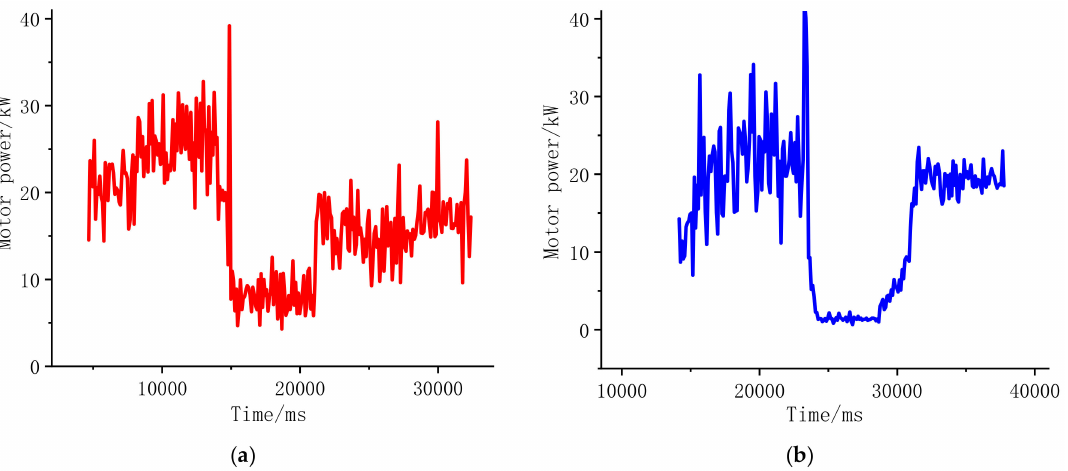
Figure 22. Electric motor power comparison curve under different modes. ( a ) Power of constant speed control; ( b ) power of variable speed